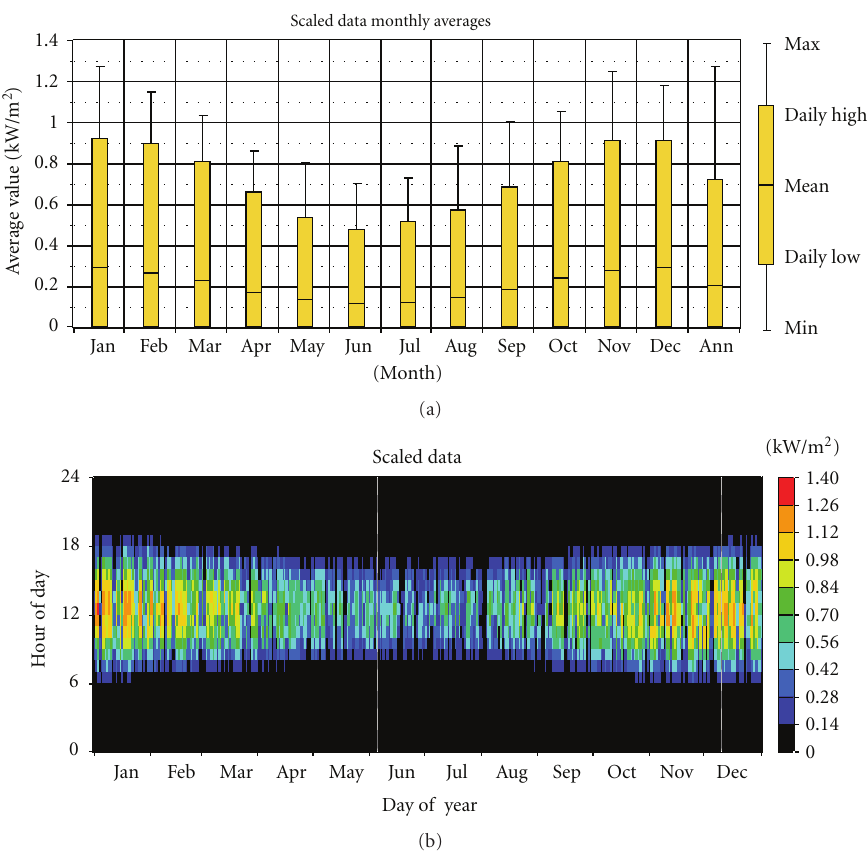
Figure 3: Incident solar radiation on a horizontal plane, obtained with software